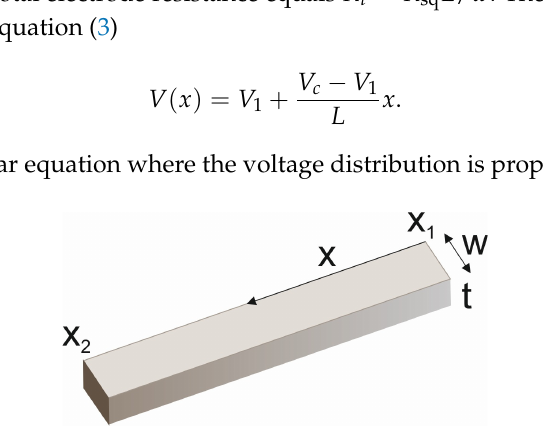
Figure 3. Three-dimensional layout of the rectangular transmission